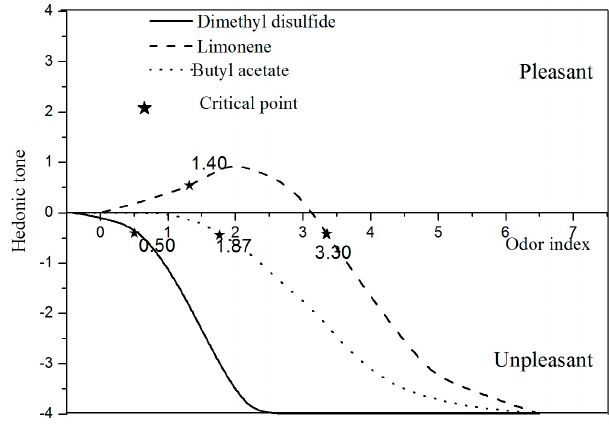
Figure 4. Comparison of the behavior curves of the three typical odorants.